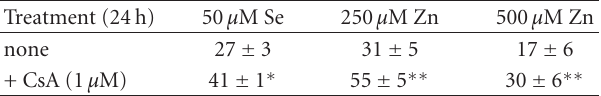
Table 1: Action of cyclosporine A on AS-30D cell death produced by high concentrations of Zn 2+ and